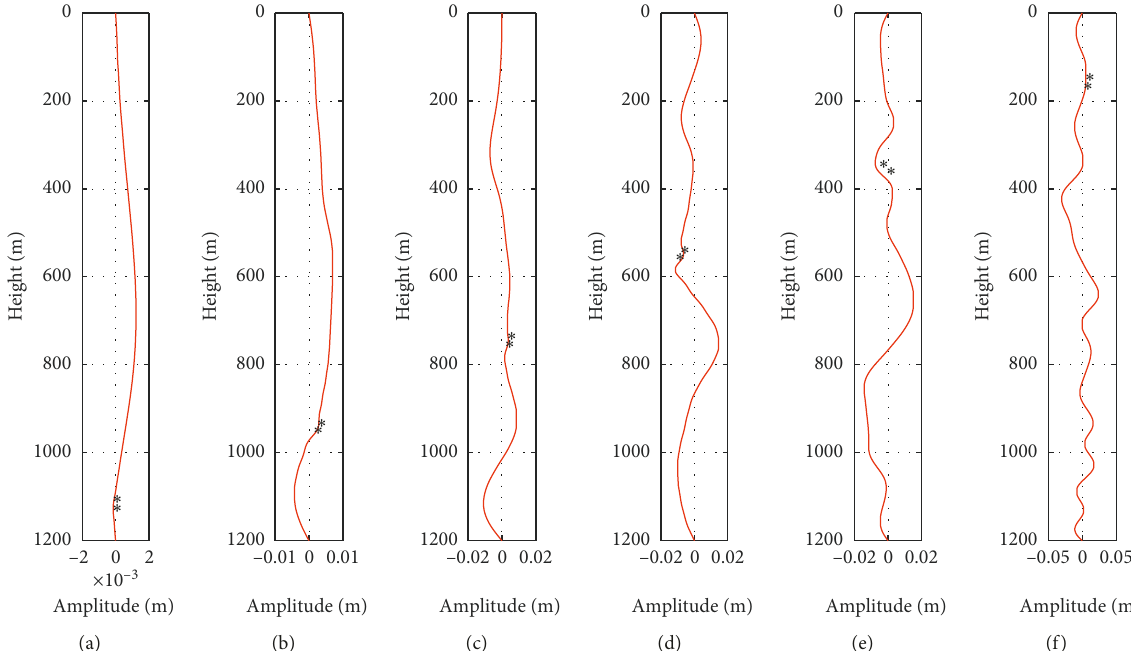
Figure 26: Transverse displacement of the guiding rope of the traction system at different